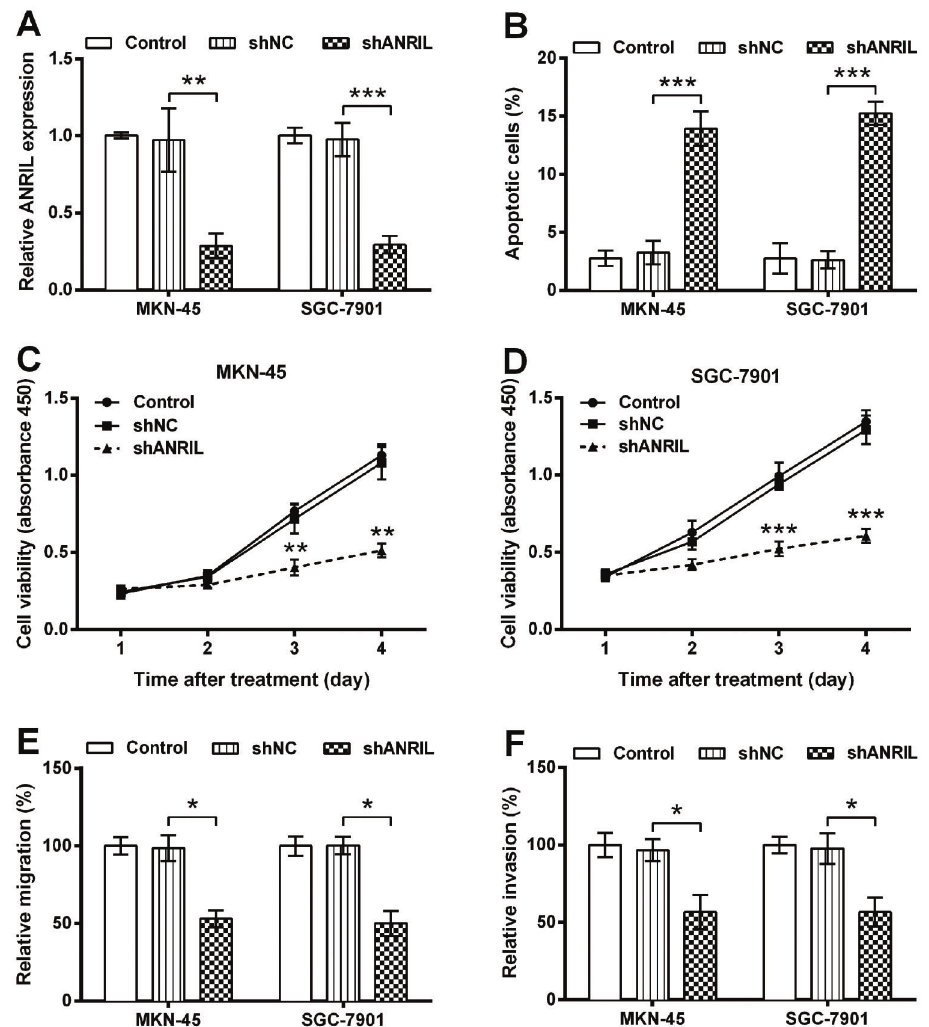
Figure 2. Knockdown of antisense non-coding RNA in the INK4 locus (ANRIL) inhibited cell viability, migration, and invasion, and pro- moted apoptosis. Untreated cells acted as control. A , Transfection ef fi ciency in MKN-45 and SGC-7901 cells tested by qPCR. GAPDH acted as an internal control. B , Rate of apoptotic cells detected by fl ow cytometry. C and D , Cell viability determined by CCK-8 assay. The migration ( E ) and invasion ( F ) were measured by Transwell assay. shANRIL: pENTR TM /U6 vector carrying small hairpin RNA targeting ANRIL; shNC: pENTR TM /U6 vector carrying a non-targeting sequence; qPCR, quantitative real-time PCR; CCK-8, Cell Counting Kit-8. Data are reported as means ± SD.*P o 0.05; **P o 0.01; ***P o 0.001 (two-tailed Student ’ s t